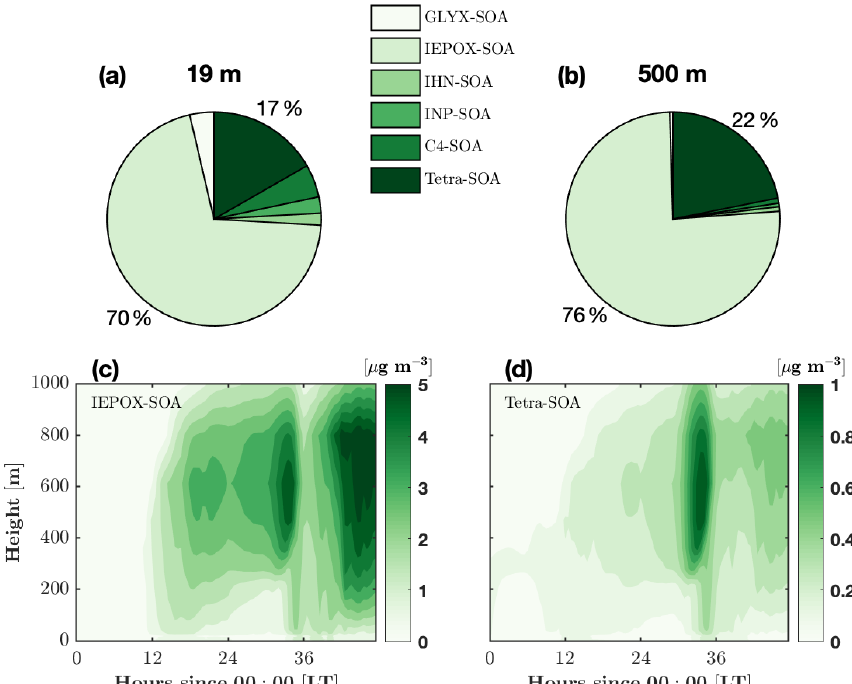
Figure 8. Composition of the average isoprene-derived secondary organic aerosol (iSOA) over the 2d period at two different heights. The composition components are the surrogate groups of GLYX (glyoxal and methylglyoxal), IEPOX (isoprene-epoxydiol, isoprene-carbonyl- hydroxy-epoxide, and hydroxy methyl methyl-a-lactone), IHNs (isoprene hydroxy nitrates), INPs (nitrooxy hydroperoxides), C4 nitrate, and tetrafunctionals. Details about the surrogate groups can be found in Section 2.5. Composition of iSOA at 19m (a) and 500m (b) . Isoprene- epoxydiol aerosols (IEPOX-SOA, c ) and tetrafunctional compound aerosol (tetra-SOA, d ) as a function of time and